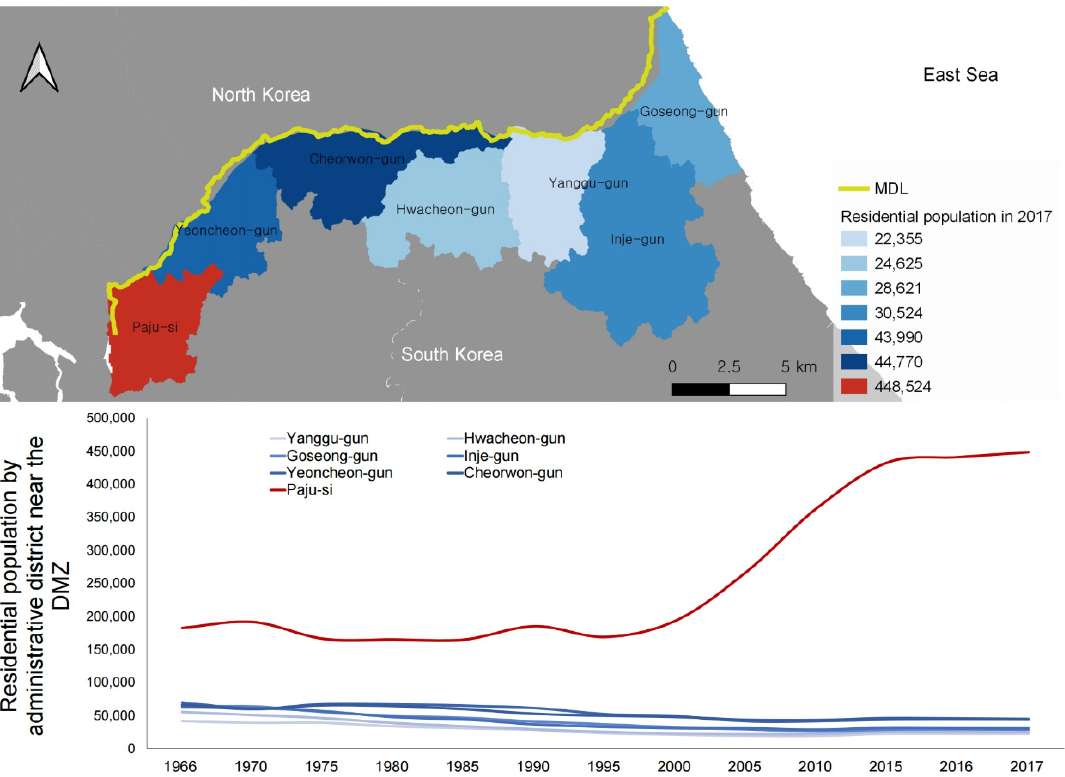
Figure 3. Residential population by administrative district near the DMZ. The population of Paju has increased rapidly since the 2000s.